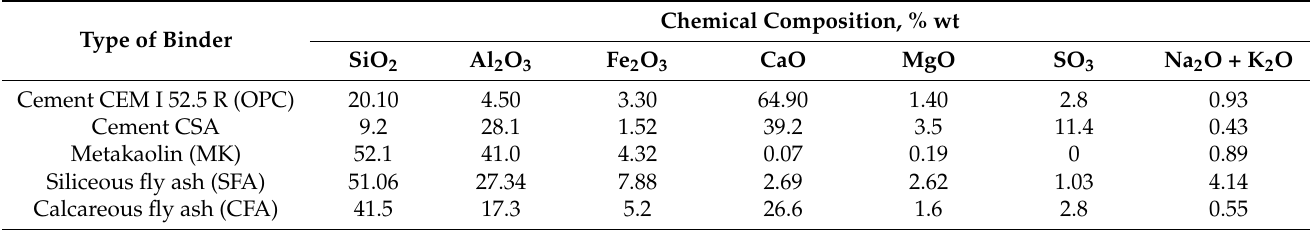
Table 1. Chemical composition of used binders.